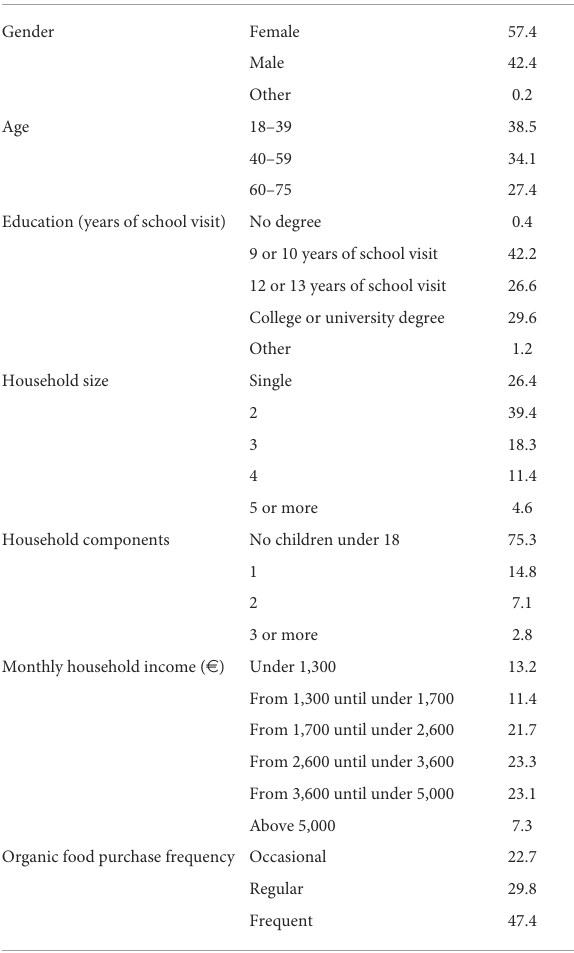
TABLE 1 Socio-demographic characteristics of the participants from the final sample ( N =